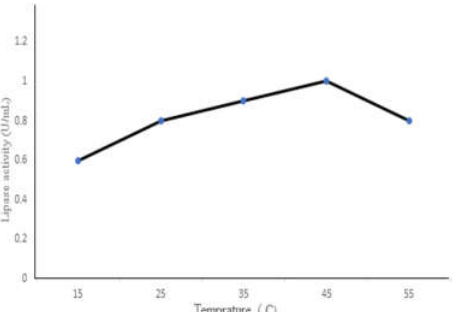
Fig. 3. Effect of temperature on lipase activity producing by AR11 in a medium containing 5% (w/v) NaCl (pH9). Results represent the means of three separate experiments, and bars indicate ±1 standard deviation